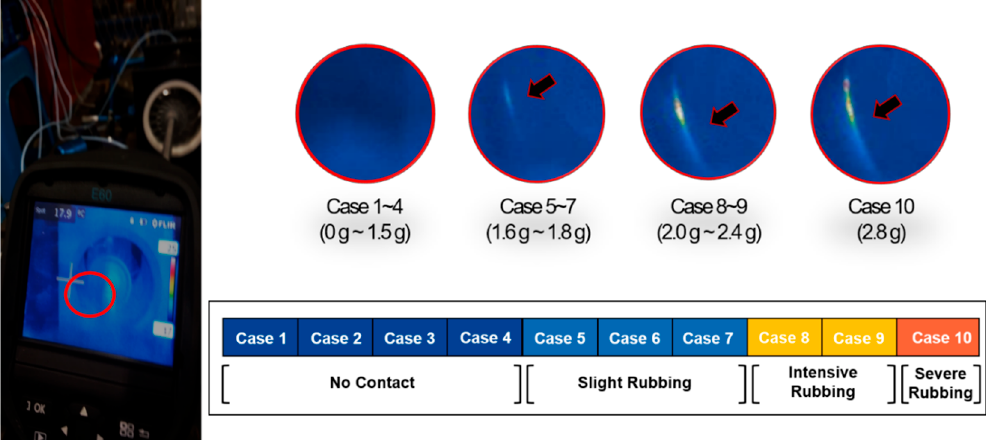
Figure 3. Changes in rubbing intensity validated using a thermal camera.